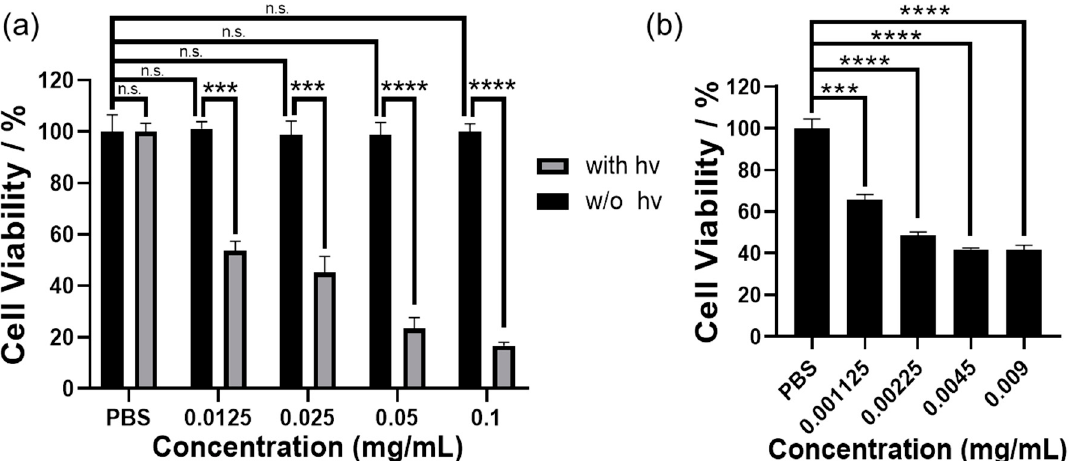
Figure 8. ( a ) Cell viability of DOX-loaded PCOFA micelles with HeLa cells for 24 h with or without light irradiation under 410 nm (28 mW/cm 2 ) for 20 min at varying concentrations (0.0125 mg/mL, 0.025 mg/mL, 0.05 mg/mL, 0.1 mg/mL); ( b ) cell viability of HeLa cells with DOX at different concentrations (1.125, 2.25, 4.5, 9 μ g/mL) for 24 h. *** p < 0.001; **** p < 0.0001.